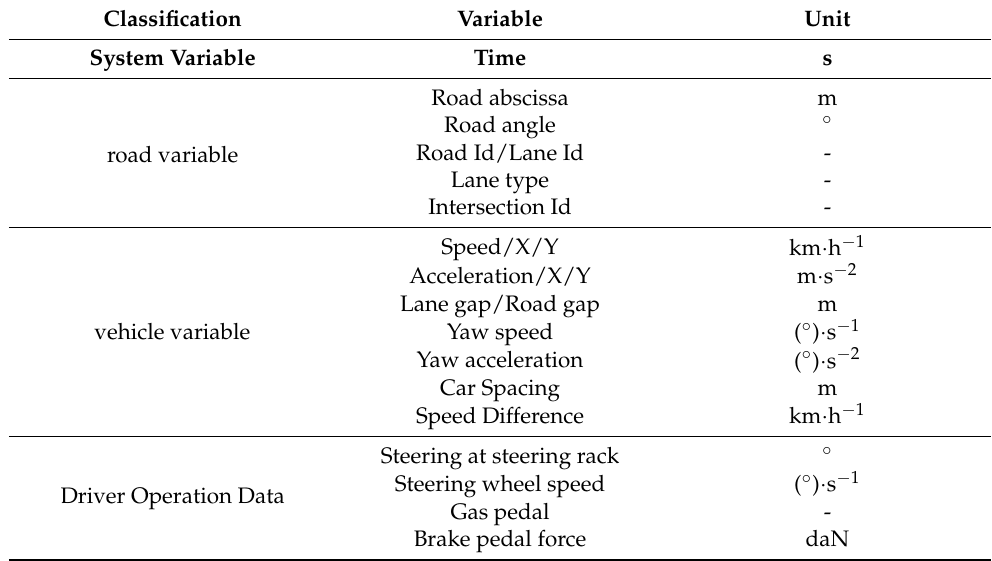
Table 4. Variables Characterizing Driving